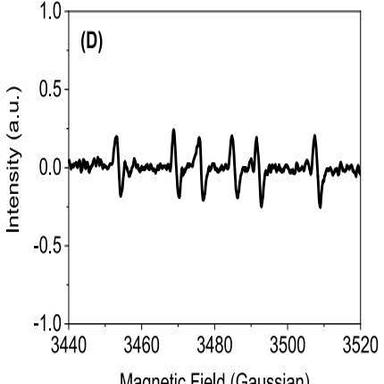
EPR spectra of irradiated (λem ca. 352 nm) aqueous DMPO (10 mM) suspensions in the following media: in the presence of Ti-γAl2O3 (A); in the presence of Ti-γAl2O3 and CHL (0.1 M) (B); in the presence of Ti-γAl2O3 and TBA (0.1 M) (C); in the presence of TiγAl2O3 and FFA (0.1 M) (D). EPR spectra of irradiated (50 W HBO lamp using a 320 nm cut-off filter) suspensions of DMPO (10 mM) in DMSO in the following media: in the presence of γAl2O3 (E); in the presence of Ti-γAl2O3 (F). 1 mg/mL of the photocatalyst was